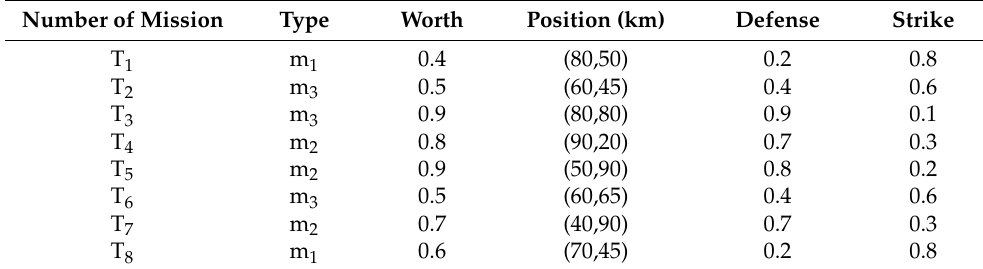
Table 6. Parameters of eight mission objectives.